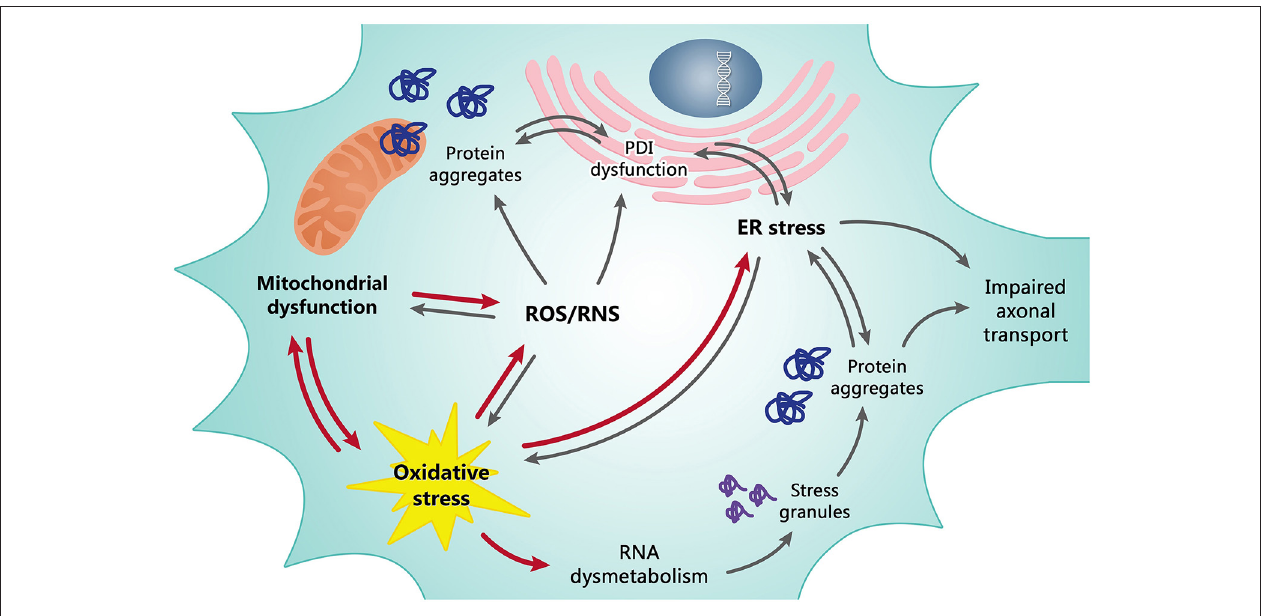
correlated detrimental effects as the formation of misfolded protein leading to insoluble cytosolic and mitochondrial aggregates, impaired axonal transport and alteration of the enzymatic activity of PDI. The line between cause and effect of individual events is however often difficult to draw since they are all tightly dependent/connected. Red arrows may be considered as primary causes, grey arrows as secondary